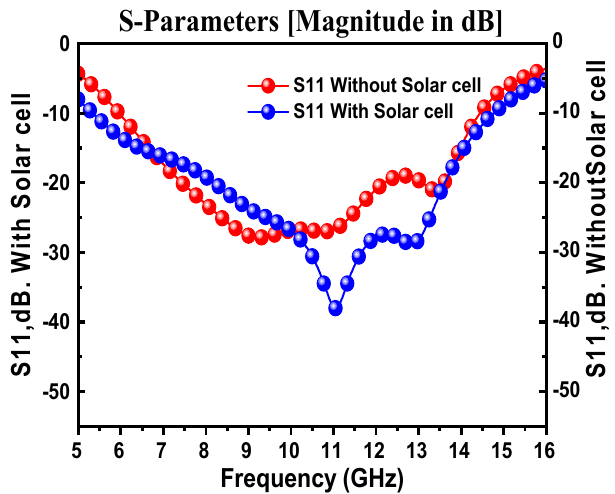
Figure 4. Simulated S11 for the proposed CPW-fed monopole antenna with and without the presence of organic solar cell.